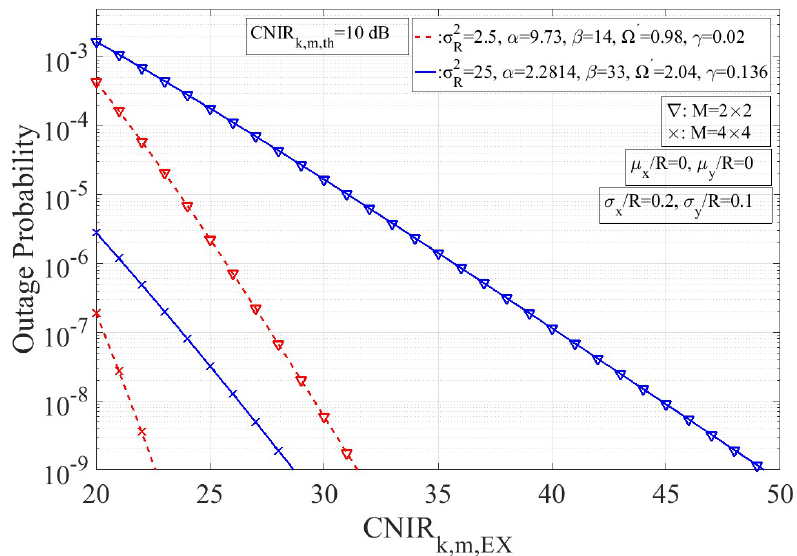
Figure 7. The OP for the CDMA RoFSO link with receivers’ diversity for both directions, over strong turbulence and weak PE impact as a function of the CNIR k,EX per branch.